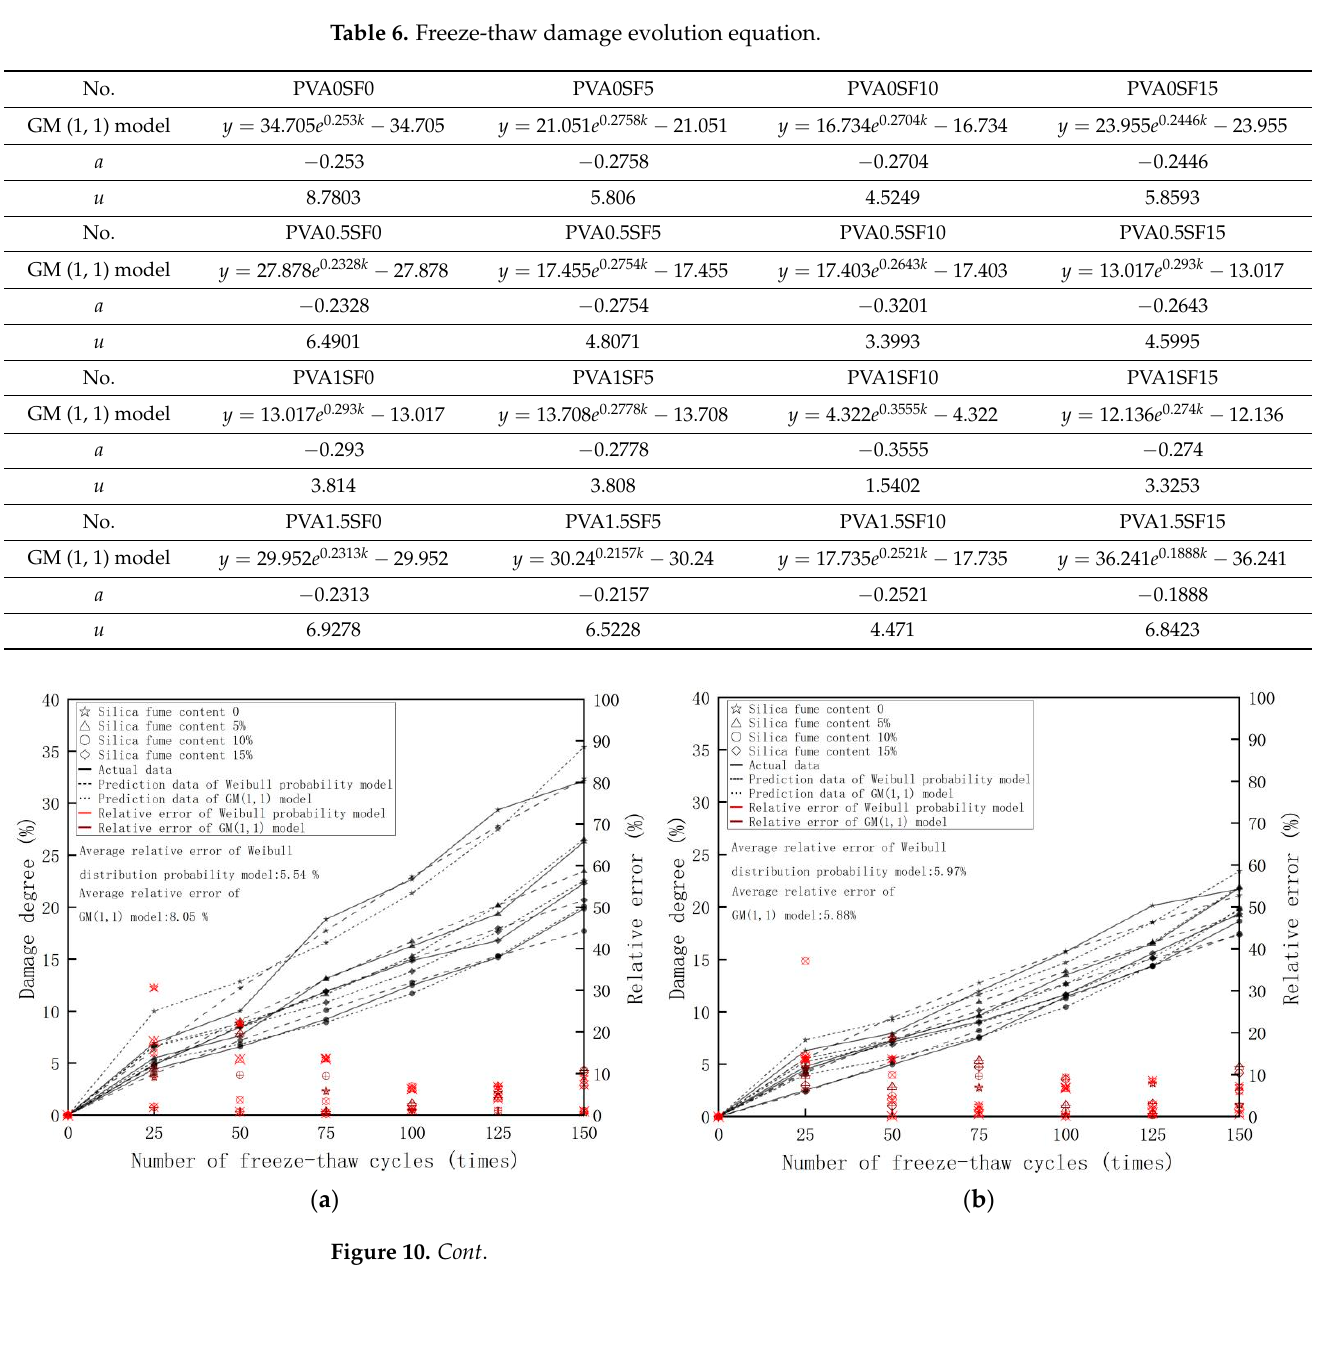
Table 6. Freeze-thaw damage evolution equation.